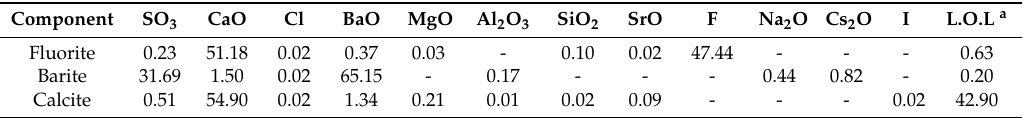
Table 1. Chemical composition of the pure fluorite, barite and calcite (%).